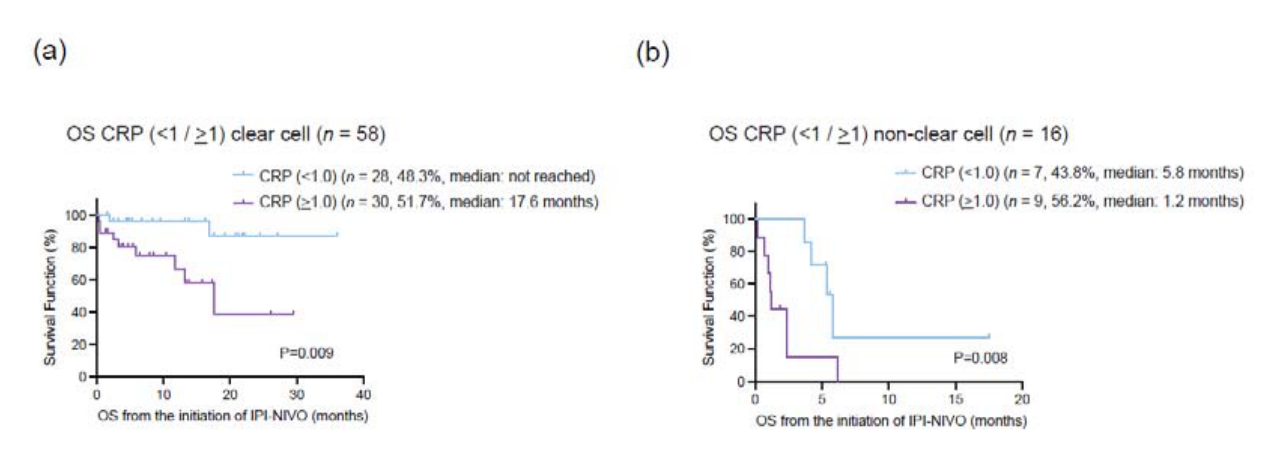
Figure 3. ( a ) Kaplan–Meier curves for overall survival (OS) in 58 clear cell renal cell carcinoma (ccRCC) according to the cut-off of serum C-reactive protein (CRP) 1.0 mg/dL. ( b ) Kaplan–Meier curves for overall survival (OS) in 16 non-clear cell RCC (nccRCC) according to the cut-off of serum C-reactive protein (CRP) 1.0 mg/dL.